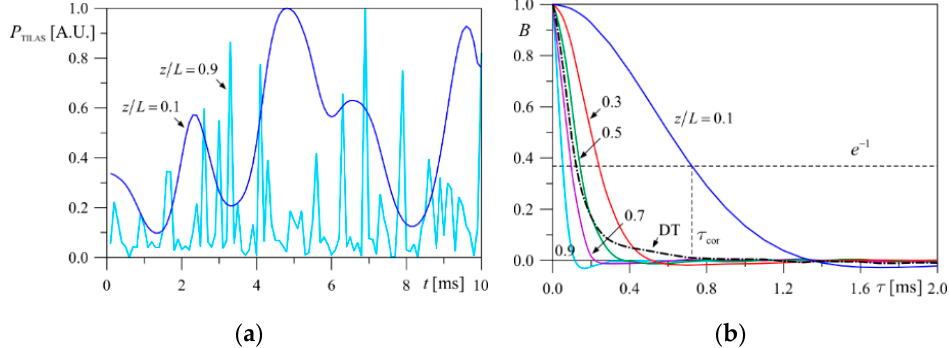
Figure 3. ( a ) Characteristic time dependencies of the TILAS received power signal P TILAS ( t ) computed over the 10-ms interval for a single spatially localized turbulence layer with C 2 n = 10 − 14 m − 2/3 ( r 0 = 4.1 cm) and L 0 = 4 m positioned at z = 0.1 L (blue line) and z = 0.9 L (sky-blue line). ( b ) Autocorrelation functions B ( τ ) obtained for five different locations of the turbulence layer of strength r 0 = 4.1 cm: z = 0.1 L , 0.3 L , 0.5 L , 0.7 L , and 0.9 L , denoted by blue, red, green, purple, and sky-blue lines, respectively. The dash-dotted black line in ( b ) shows B ( τ ) obtained for the homogeneously distributed turbulence (DT) model with C 2 n = 2 × 10 − 15 m − 2/3 ( r 0 = 4.1 cm) and L 0 = 4 m. Here, the TILAS outgoing beam wavelength λ = 1.064 µm, the beam radius W 0 = 1.5 cm, the TILAS transceiver aperture diameter d TILAS = 3.3 cm, the propagation path length L = 7 km, the target size d T = 1 cm, and the target speed v T = 200 m/s.